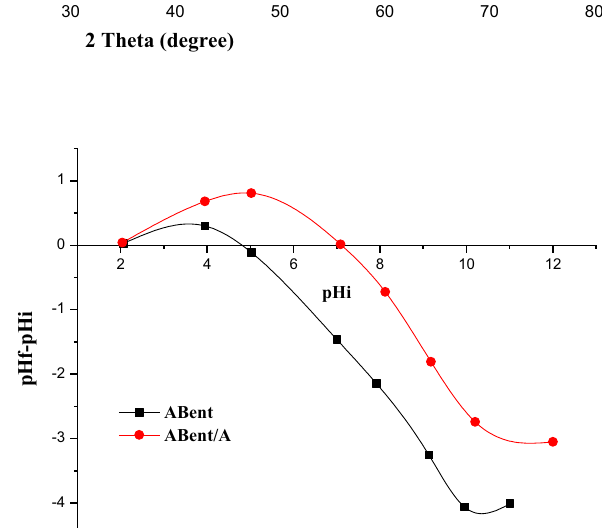
Fig. 4 Zero charge points of ABent and